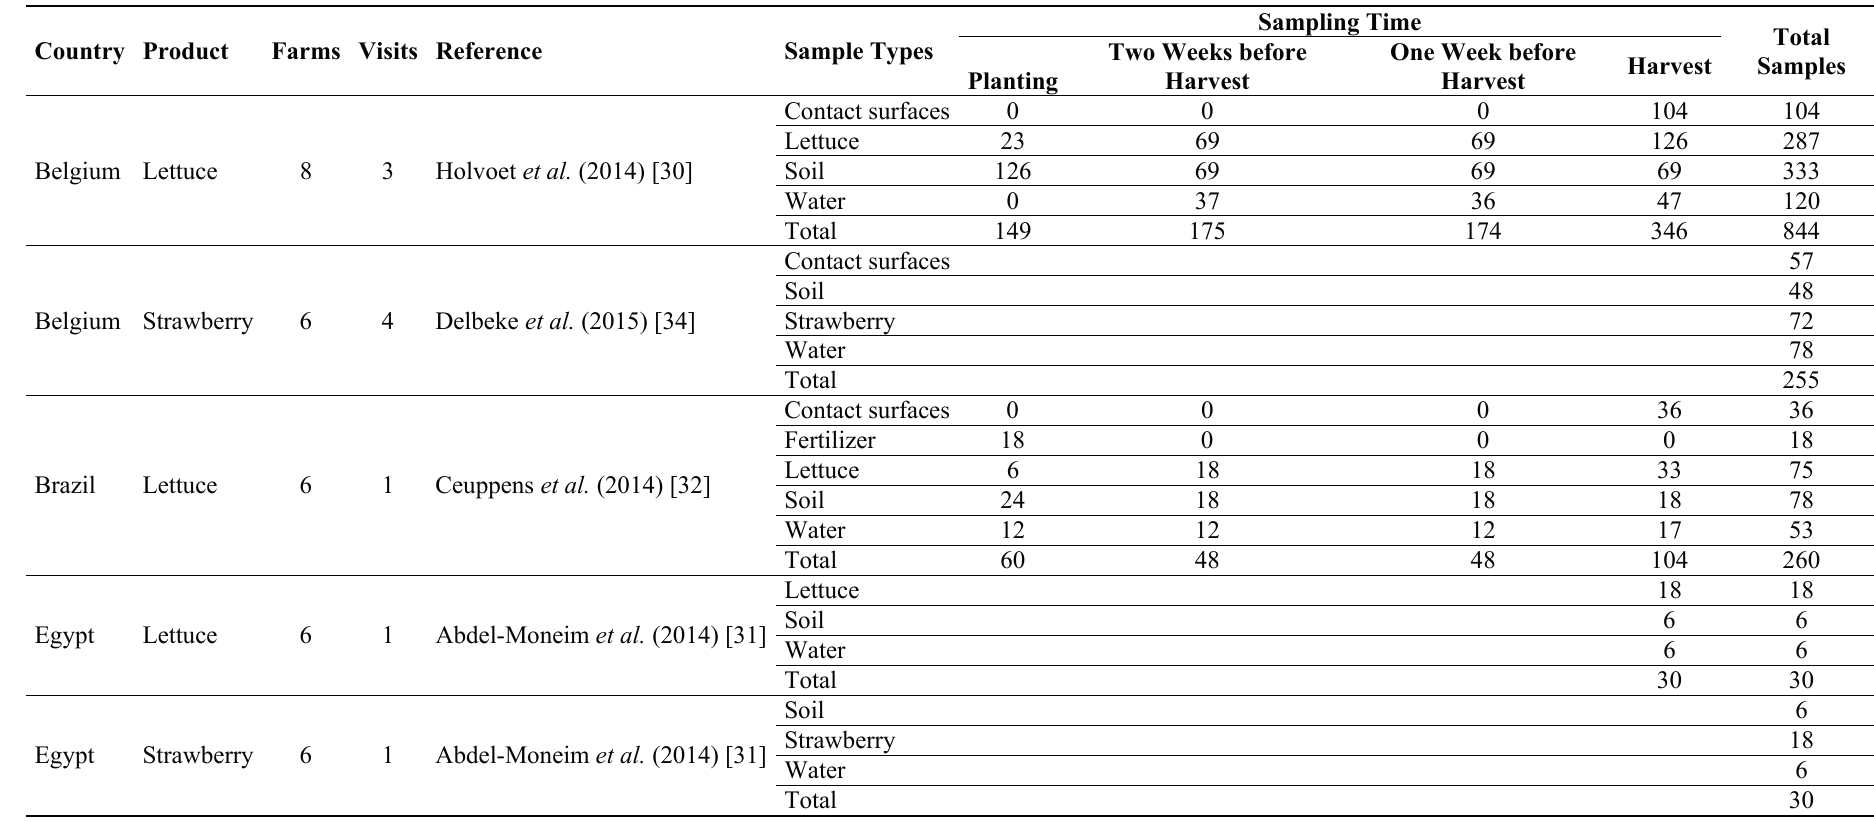
Table 1. Overview of the samples taken per country and per fresh produce